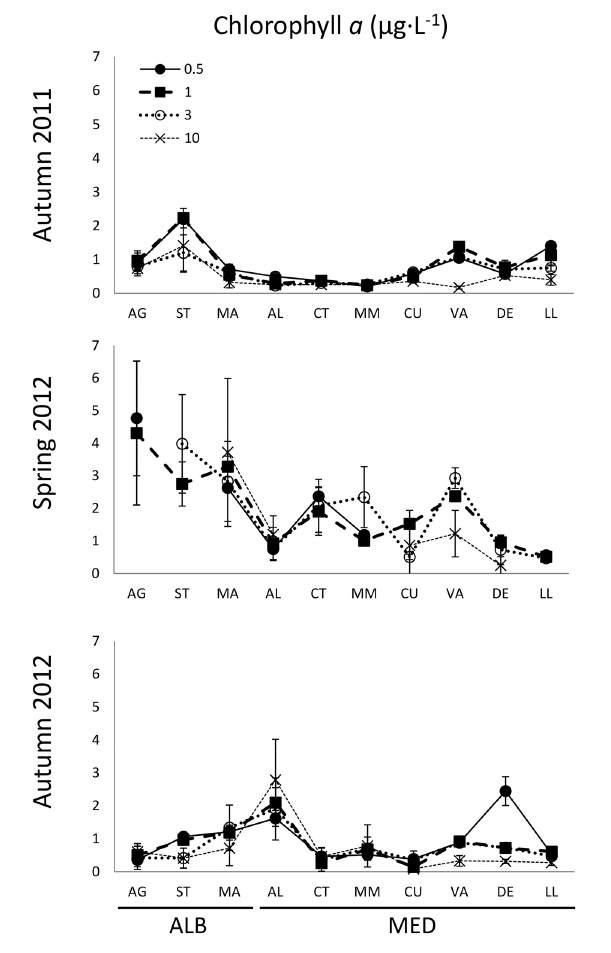
and autumn 2012. Transect codes as in Figure 1